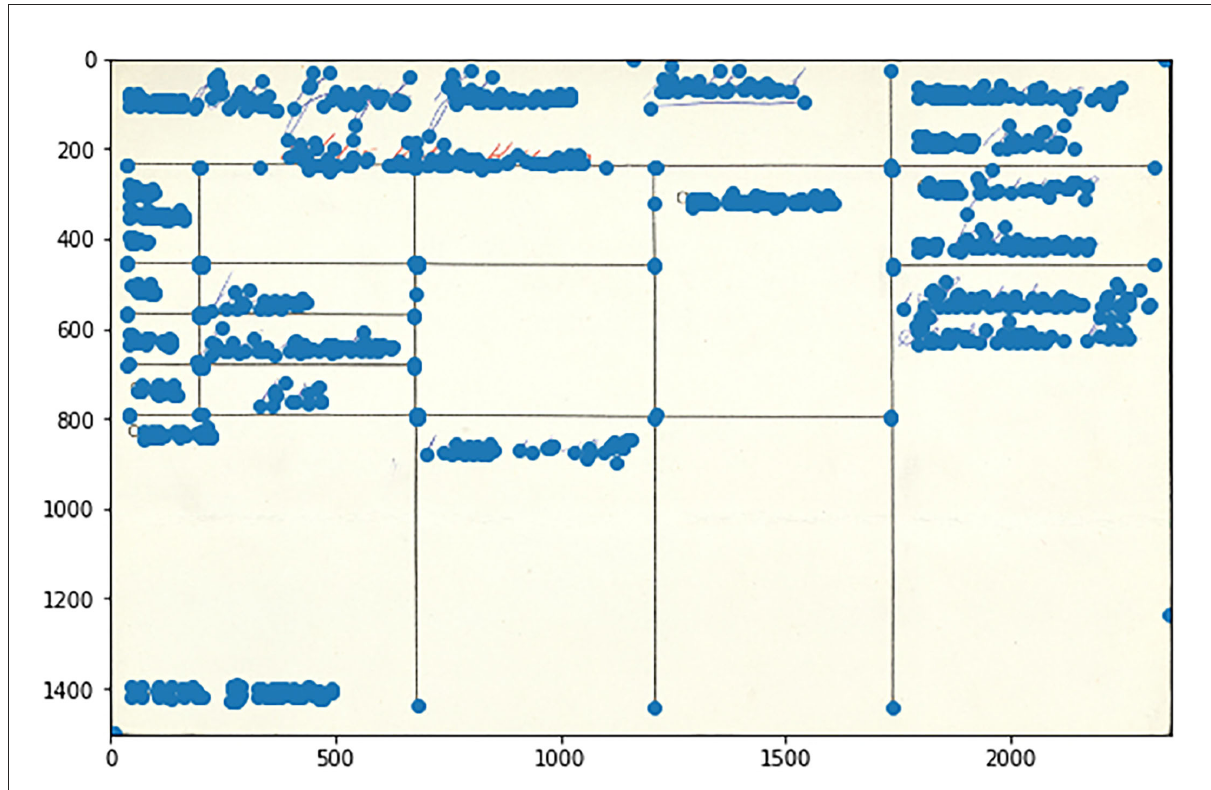
FIGURE2 Script edges on a migrant registration card—(source—emigrant registration